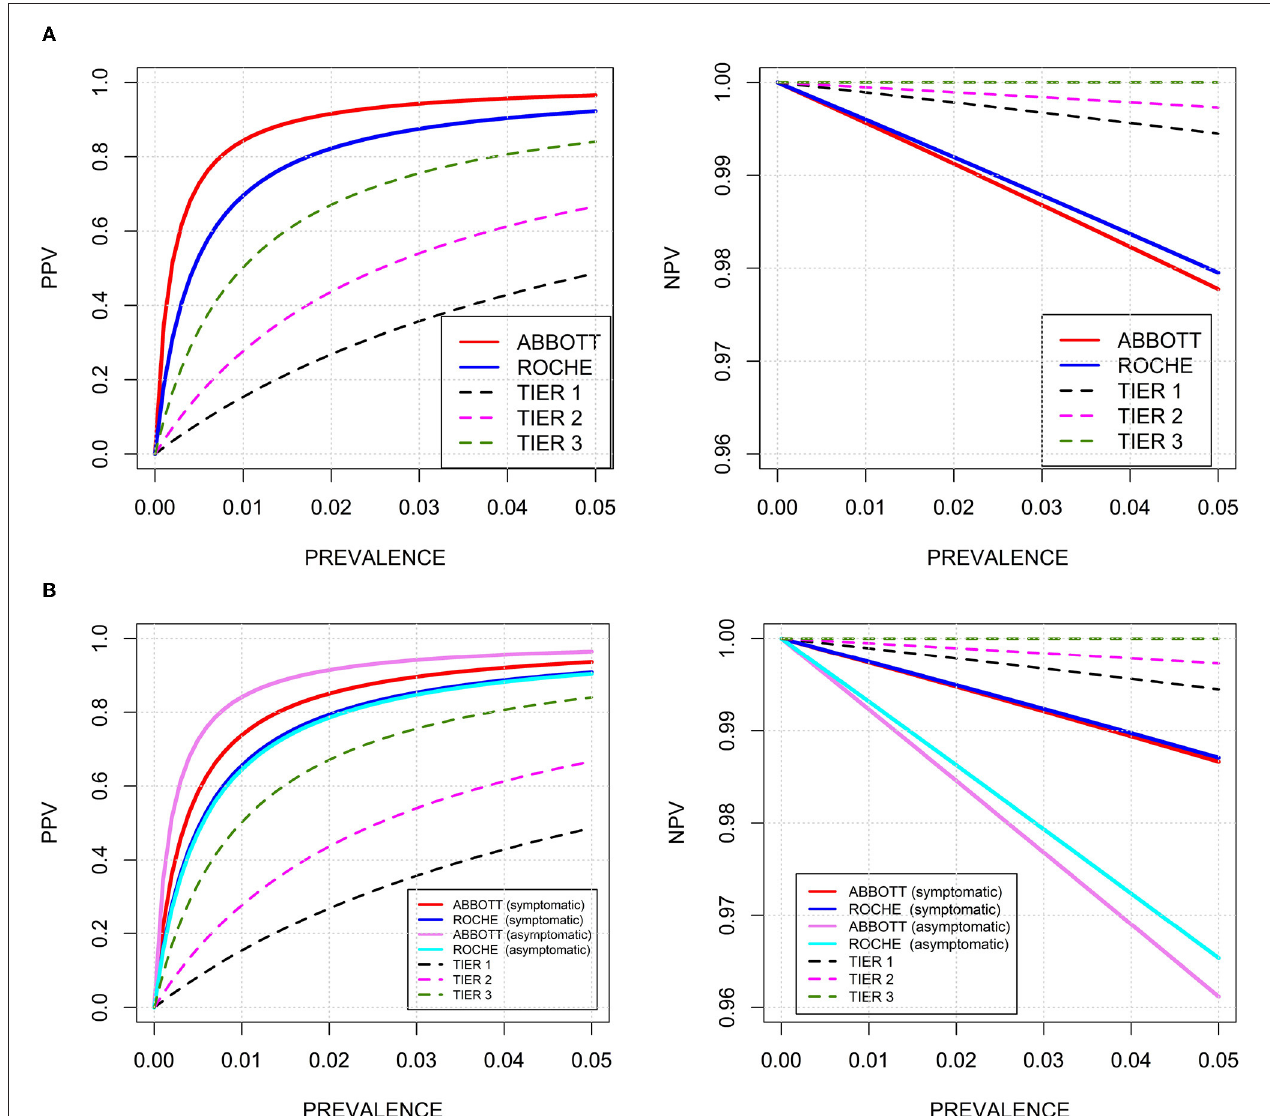
FIGURE 3 | Predictive values of positive tests (PPV, left) and predictive values of negative tests (NPV, right) of two commercial RDTs for SARS-CoV-2-associated antigens in relation to disease prevalence rates up to 0.05. Black dotted line: hypothetical sensitivity and specificity of 90 and 95% (tier 1); magenta dotted line: hypothetical sensitivity and specificity of 95 and 97.5% (tier 2); green dotted line: hypothetical sensitivity and specificity of 100 and 99% (tier 3). (A) Red solid line: Abbott-RDT; blue solid line: Roche-RDT; (B) stratified according symptomatic and asymptomatic study participants. Red solid line: symptomatic participants, Abbott-RDT; blue solid line: symptomatic participants, Roche-RDT; magenta solid line: asymptomatic participants, Abbott-RDT; light blue solid line: asymptomatic participants,